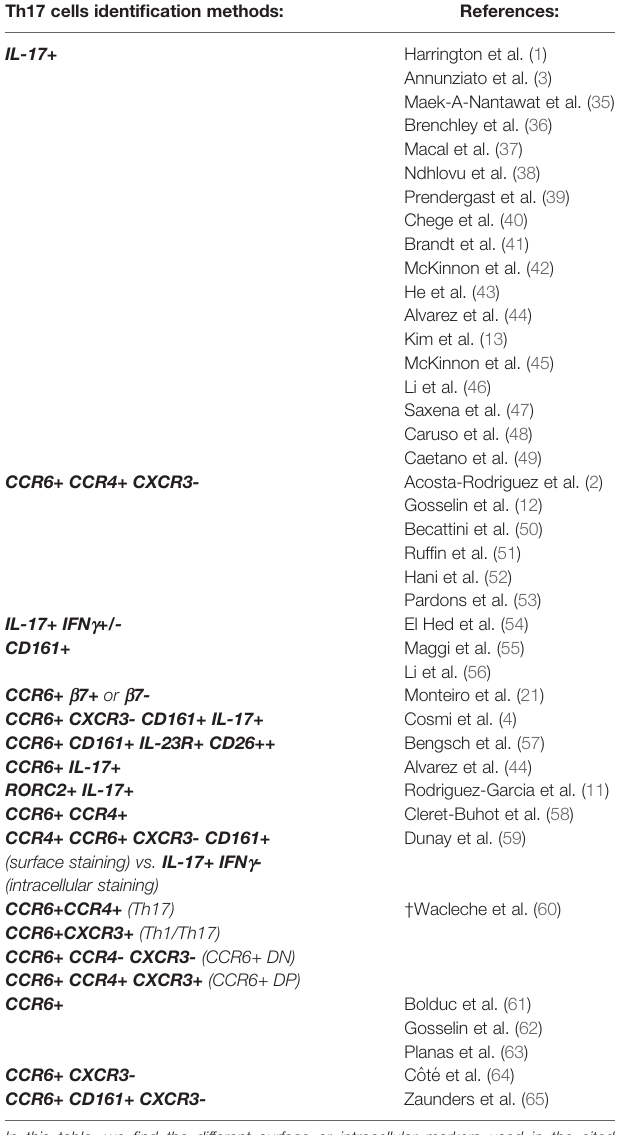
TABLE 1 | Phenotypes used to characterize and sort Th17